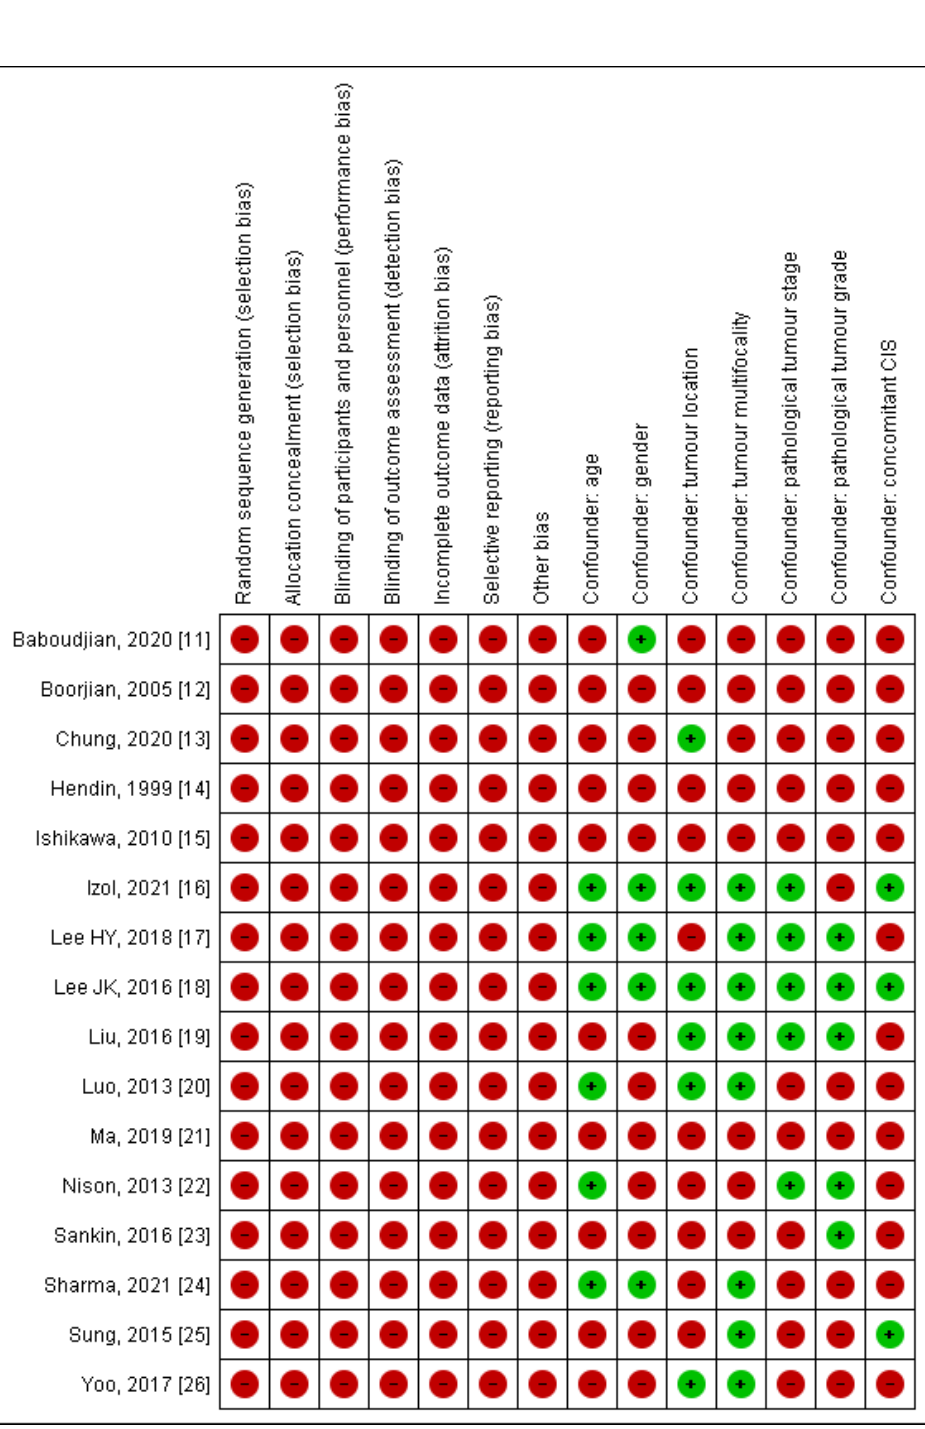
Figure 2. The risk of bias and confounding assessment for all included studies [11–26]. The green circle represents a low risk of bias and confounfing. The red circle represents a high risk of bias and confounding. CIS = carcinoma in situ.